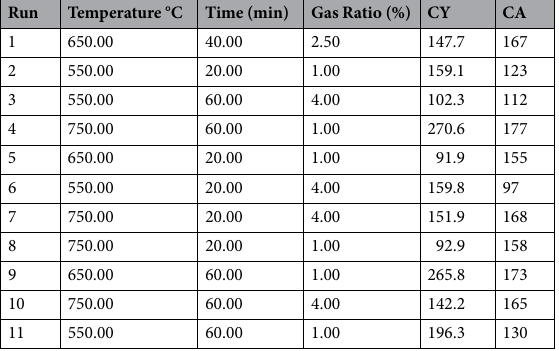
Table 1. Experimental design matrix and the value of responses based on experiment run.